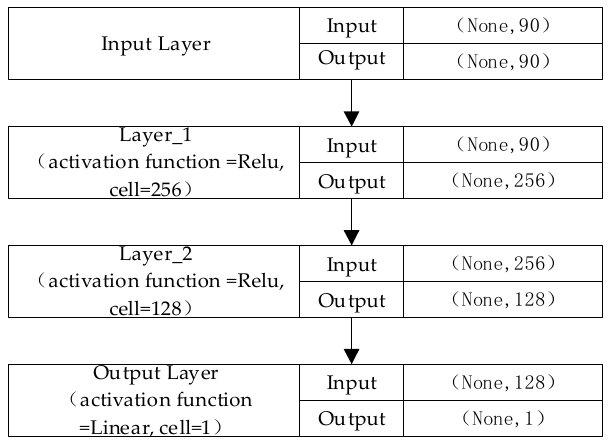
Figure A4. ANN model architecture.